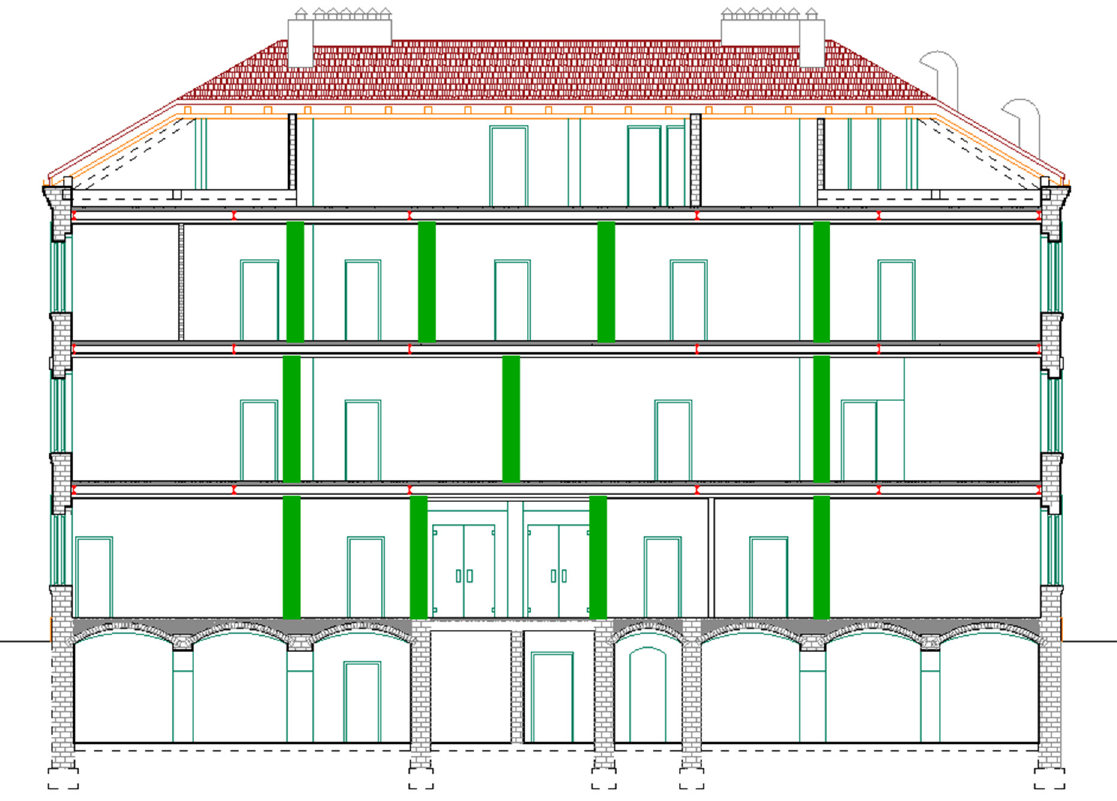
Figure 23. Proposal for the position of the new load-bearing walls and proposal for the removal and replacement of partition walls (cross-section).